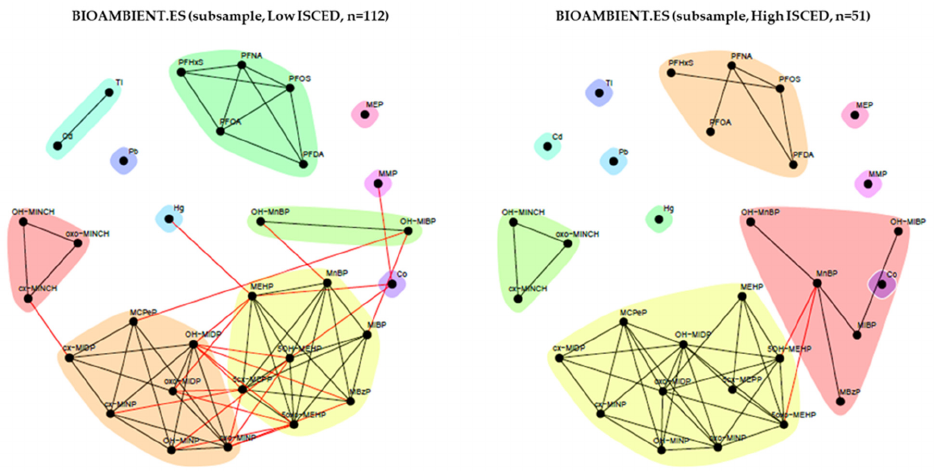
Figure 15. Stratification of the network for the BIOAMBIENT.ES dataset by education (ISCED level). Low ISCED (left panel) is defined by participants belonging to educational levels 0–4 according to the ISCED (International Standard Classification of Education) and high ISCED (right panel) is defined by participants belonging to educational level ≥ 5. Data were corrected for sex, age, BMI and smoking status. Black lines indicate dependency between nodes (biomarkers) within a community; red lines indicate dependency between nodes in different communities.